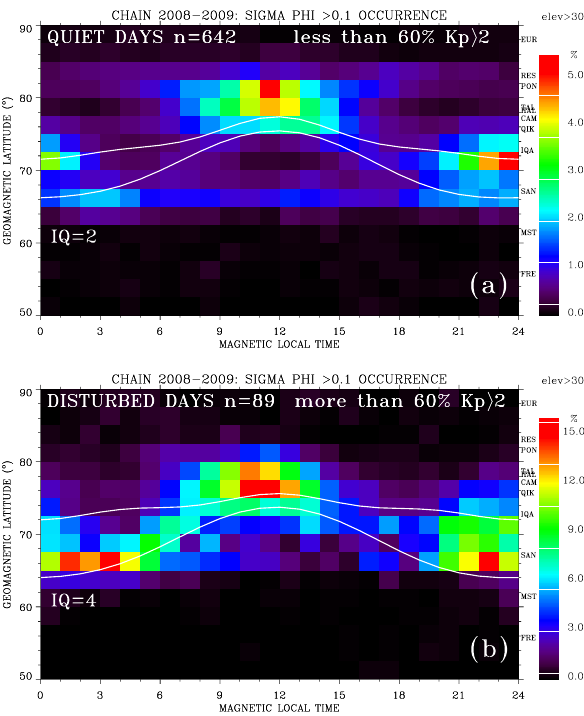
Fig. 8. Phase scintillation maps for geomagnetically (a) quiet and (b) disturbed days. Note different color